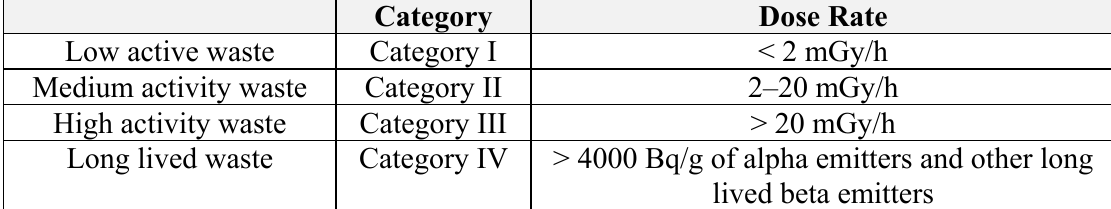
Table 2: Classification of radioactive waste by dose rate